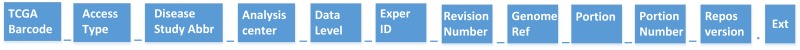
TCGA Expedition file name components.